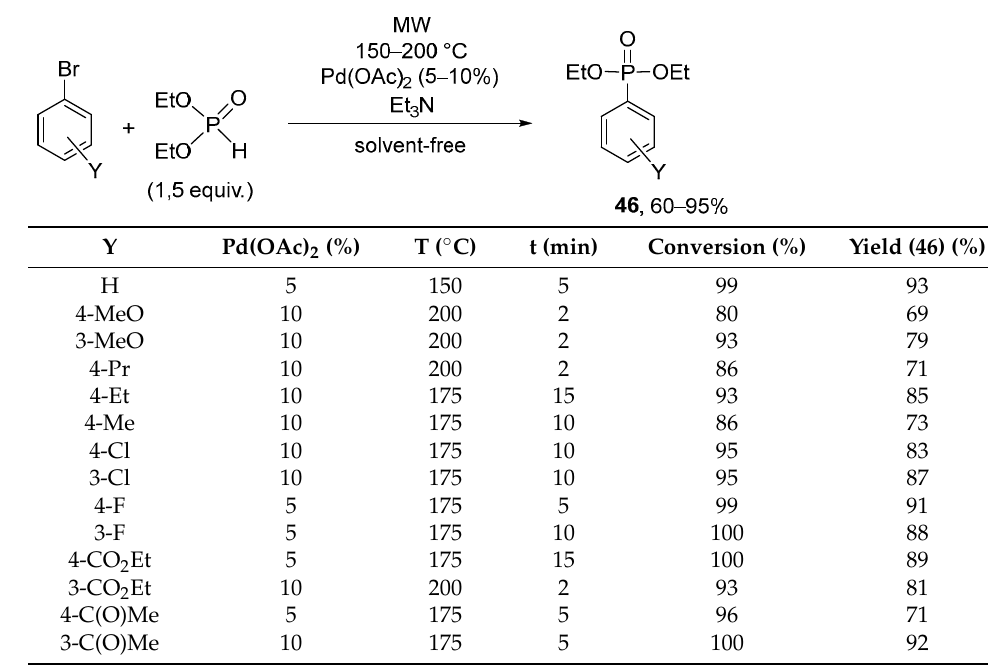
Table 15. MW-assisted Hirao reaction of bromoarenes and diethyl phosphite applying Pd(OAc) 2 as the catalyst